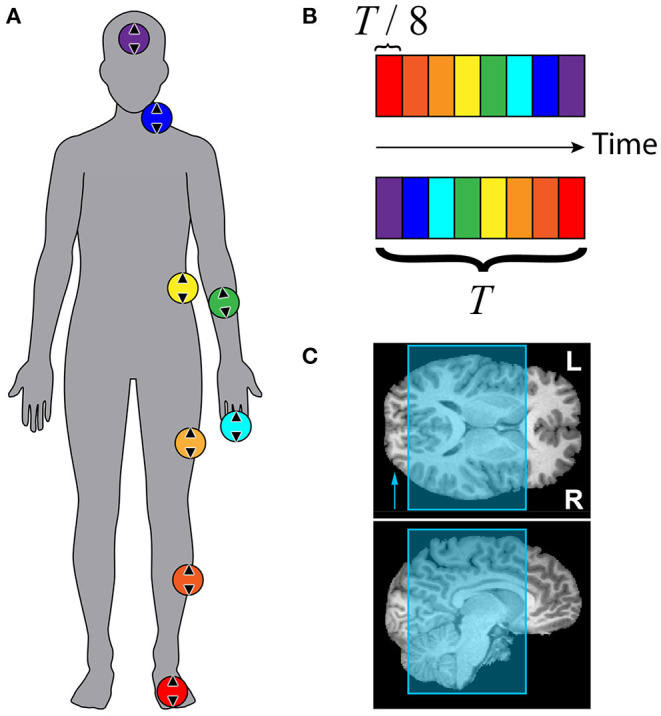
Stimulation paradigm and scan coverage for somatosensory mapping with fMRI. (A) Colored circles represent approximate stimulator locations: glabella, neck near collarbone, anterior forearm, middle fingertip, trunk beneath ribcage, thigh, shin, and volar side of foot. Arrows within circles show approximate orientation of linear actuators. (B) Colored boxes depict timing of tactile stimuli. Top: forward sequence. Bottom: reverse sequence. Total stimulation period T was 72 s (40 s for subject F). Each stimulator was active for T/8 = 9 s (5 s for subject F) before switching to the next. Each run consisted of 5 stimulation periods (9 for subject F). (C) EPI slice coverage overlaid on T1-weighted MR images. Slices were stacked along the anterior-posterior axis. Phase encoding direction was right-left, indicated by the arrow in the axial view.